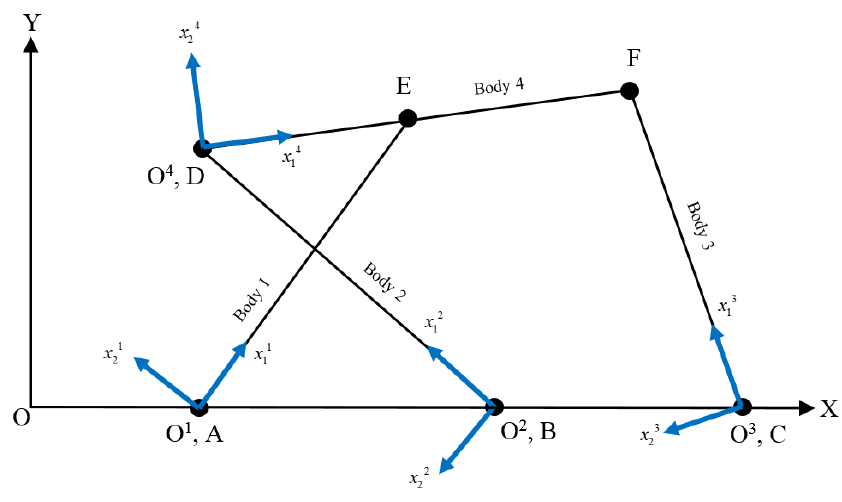
Figure 4. Assignment of the frames.